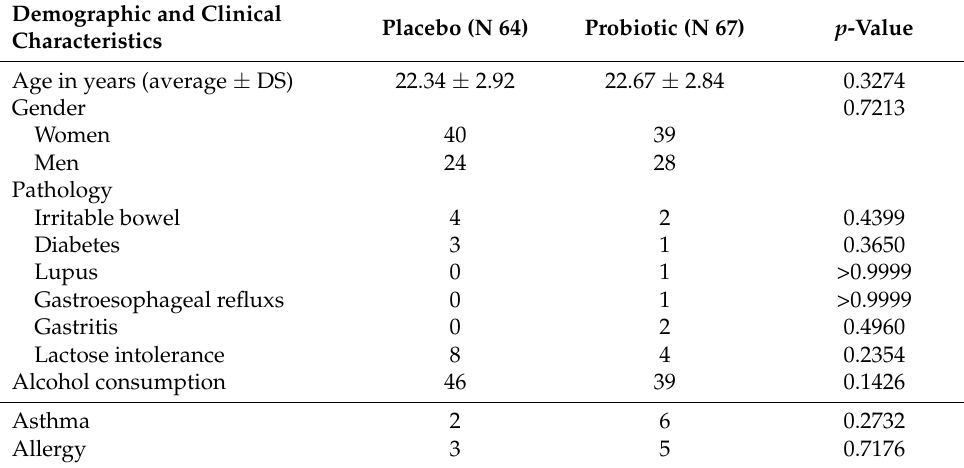
Table 1. Demographic and clinical characteristics of participants in the groups receiving probiotic- or placebo-supplemented